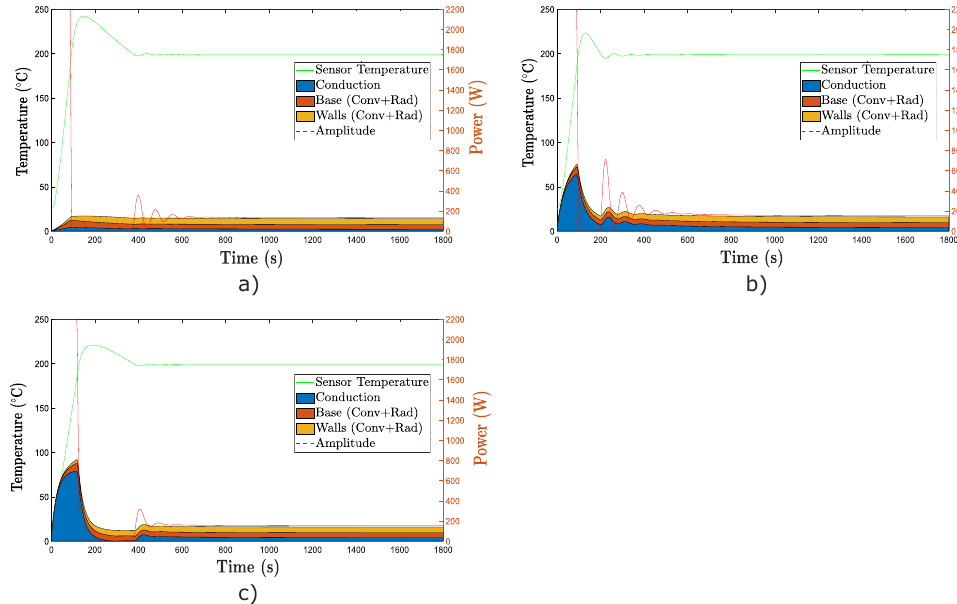
Figure 10. Temperature of the sensor (green continuous line), amplitude of the power density (red dotted line) and losses (coloured areas) of three WMF pans that only differ on its concavity, case #A ( a ), case #B ( b ) and case #C ( c ) (see Figure 4). The yellow area represents convective and radiation losses of the walls, the orange area represents convective and radiation losses of the base of the pan, and the blue area represents conduction losses to the